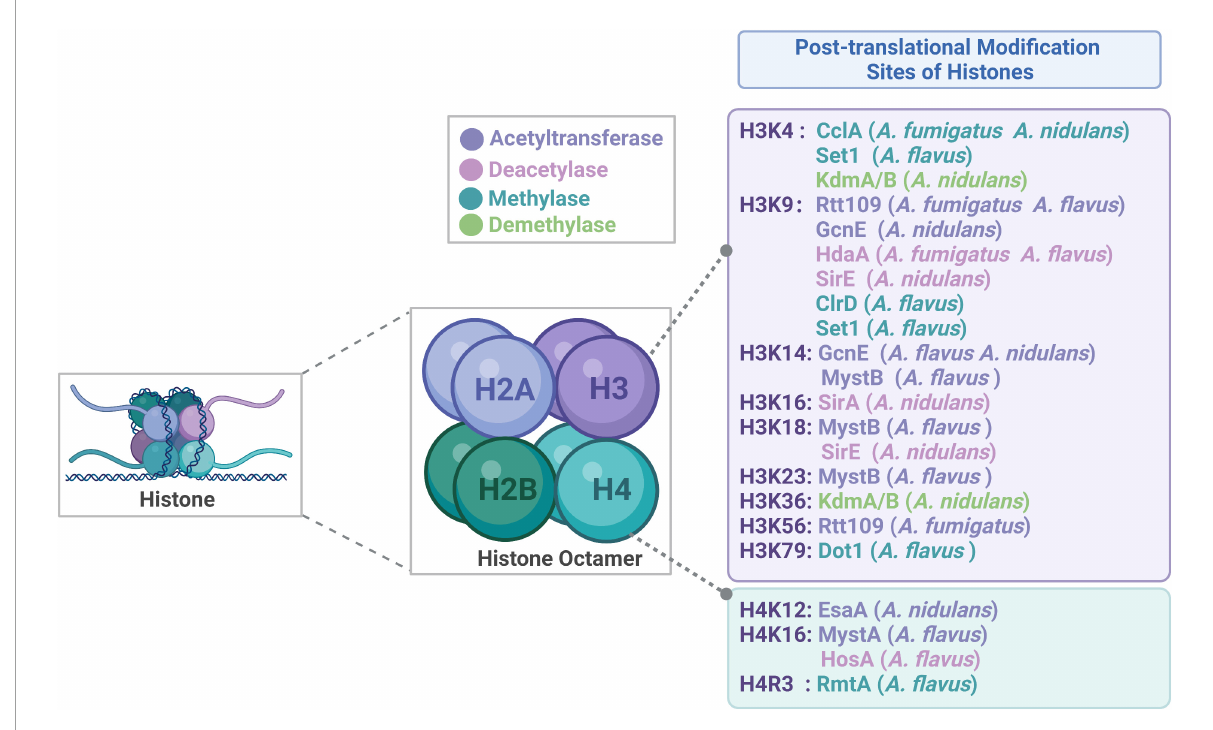
FIGURE1 Structure of histone and the sites of histone post-translational